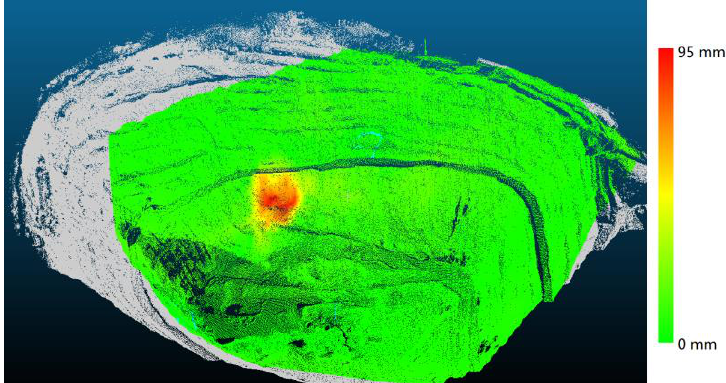
Figure 12. The deformation map geocoded over LiDAR data.